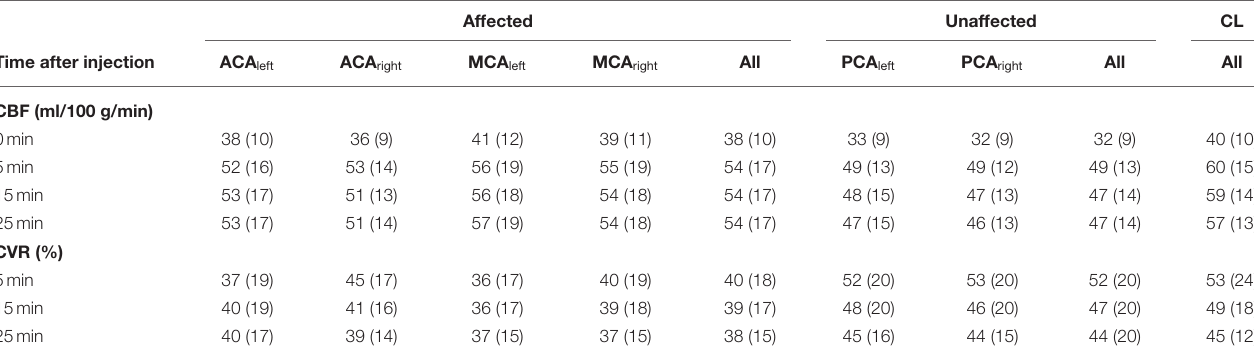
TABLE 2 | Average CBF and CVR with standard deviation for each individual vascular territory and all affected, unaffected, and unaffected contralateral vascular territories and all post-ACZ injection time points. Affected Unaffected CL Time after injection ACA left ACA right MCA left MCA right All PCA left PCA